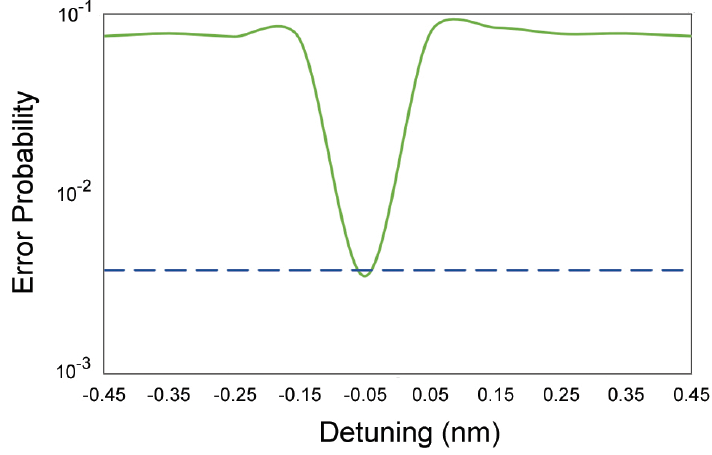
Figure 16. Error probability vs. BFL detuning at 11 Gb/s. The dashed line indicates the FEC limit at 3.8 × 10 − 3